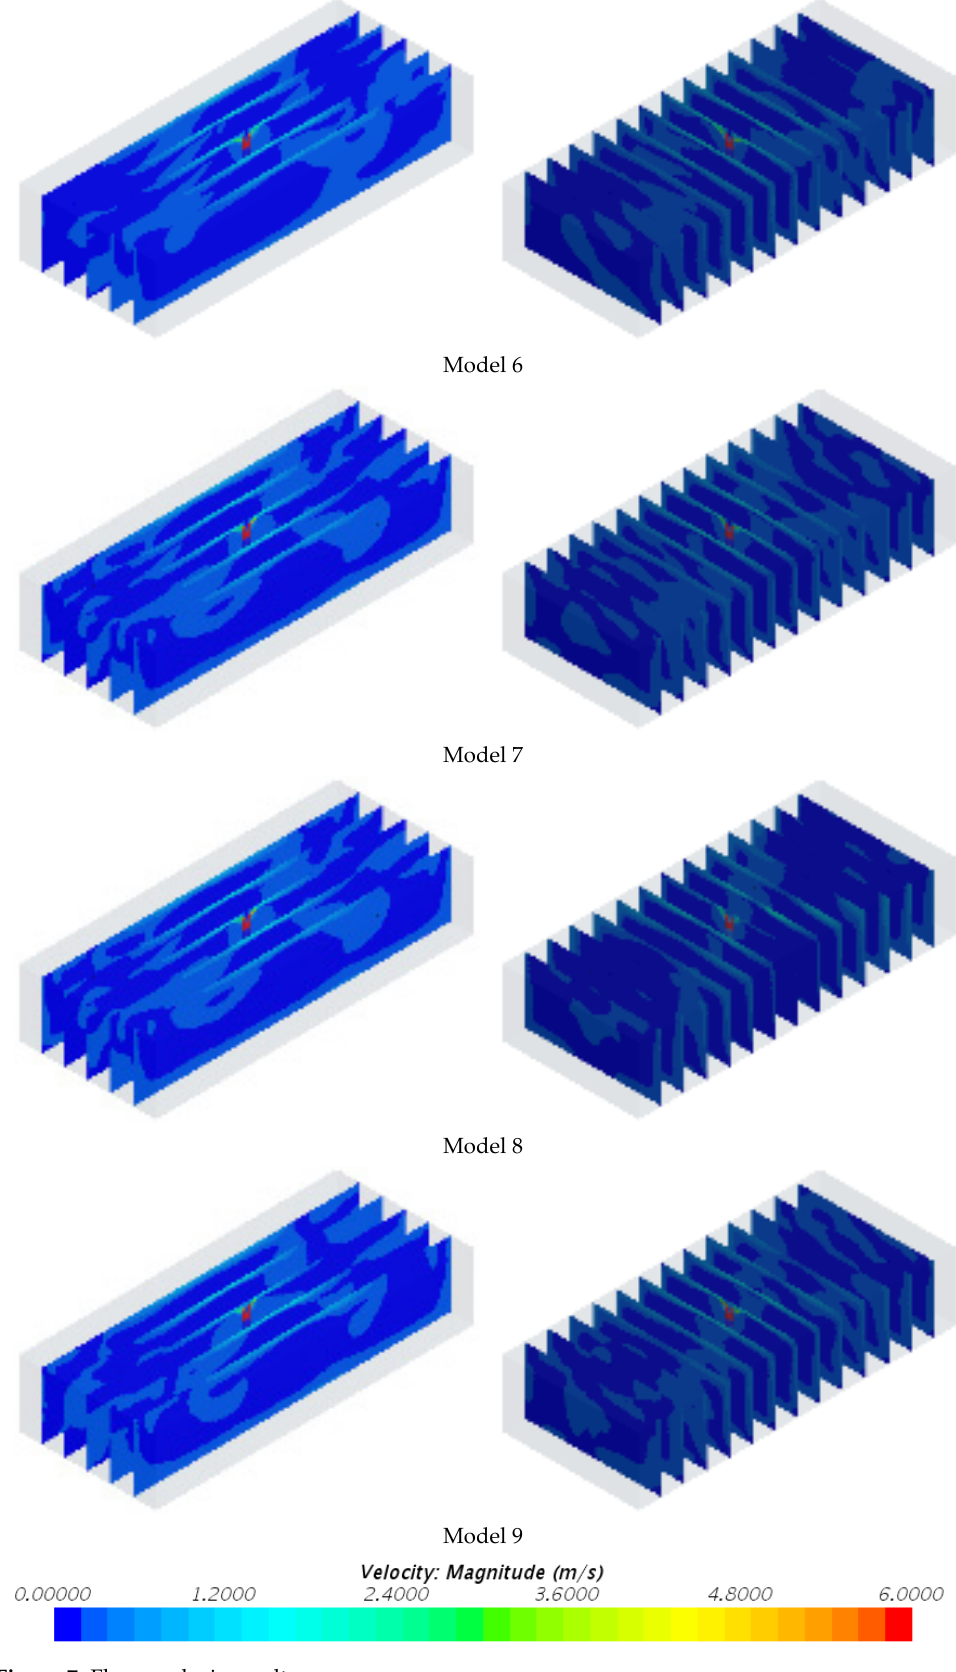
Figure 7. Flow analysis results.